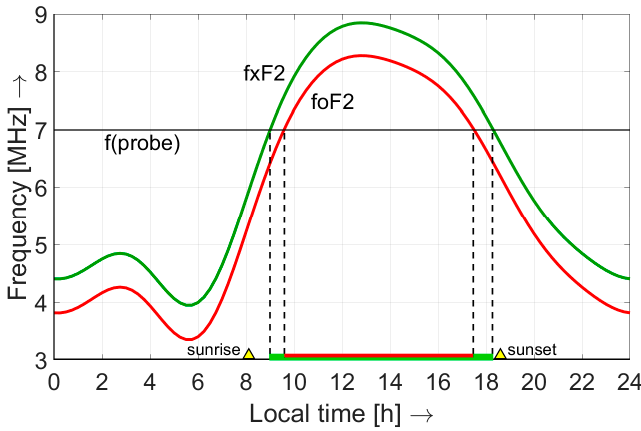
Figure 4. Modelled diurnal variation of the critical frequencies of the F2-region of the ionosphere using the International Reference Ionosphere [34]. NVIS propagation is possible when f xF2 > f probe .